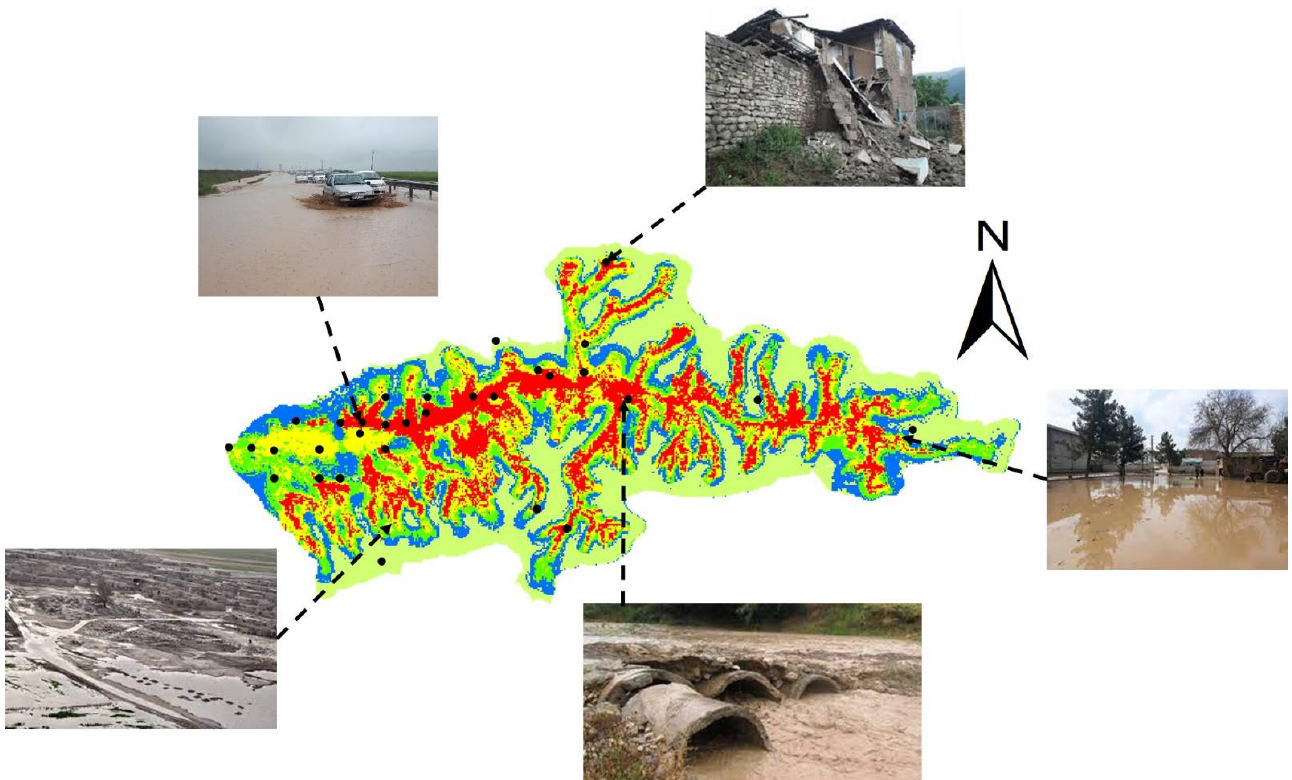
Figure 7. The location of several examples of recent flood damage in the study area.